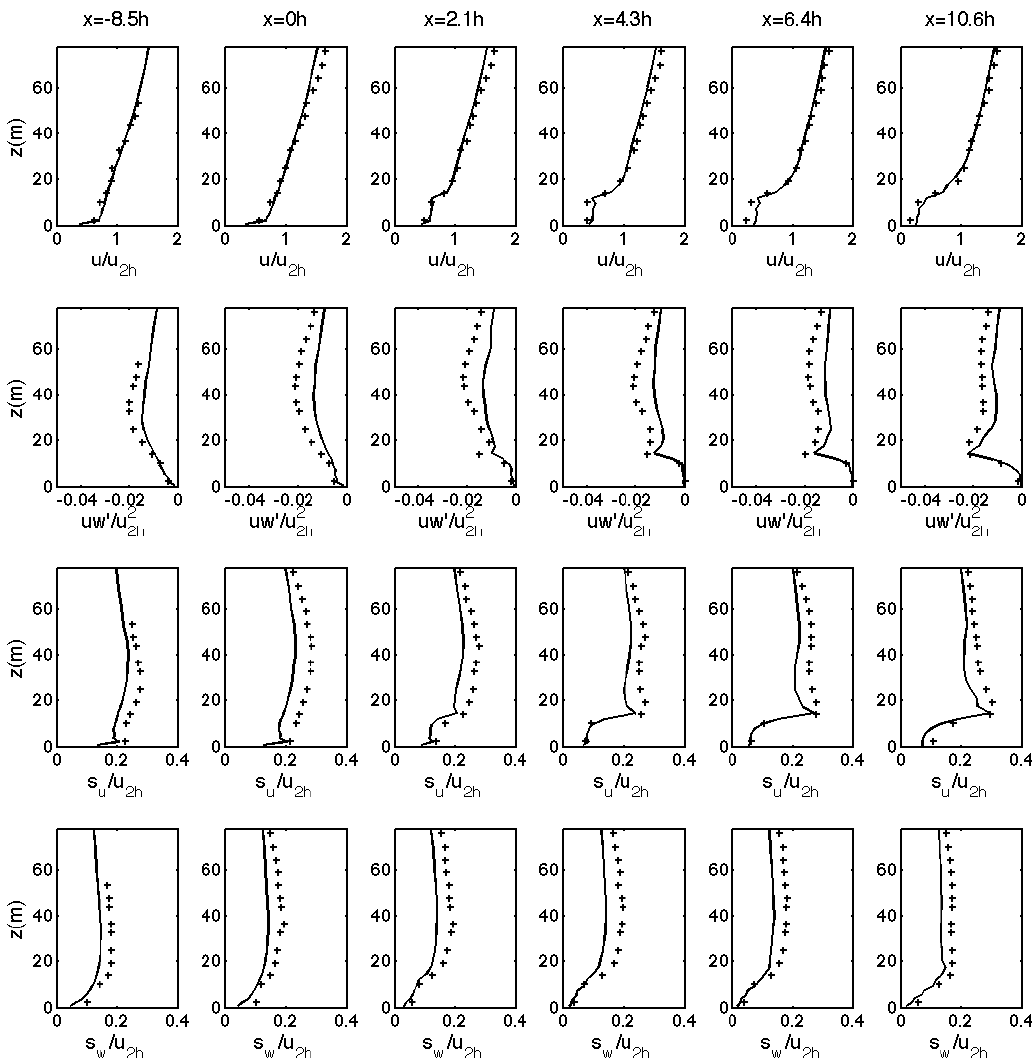
Figure A5. Simulated wind statistics over canopy Can4 with PGF4 (lines), against experimental data ( + ’s) at various location along the x -axis from − 8.5 h to 10.6 h : ( a ) u -velocity profiles; ( b ) momentum fluxes; ( c ) standard deviation of u -velocity; ( d ) standard deviation of w -velocity. u 2 h is the mean wind velocity at z = 2 h .